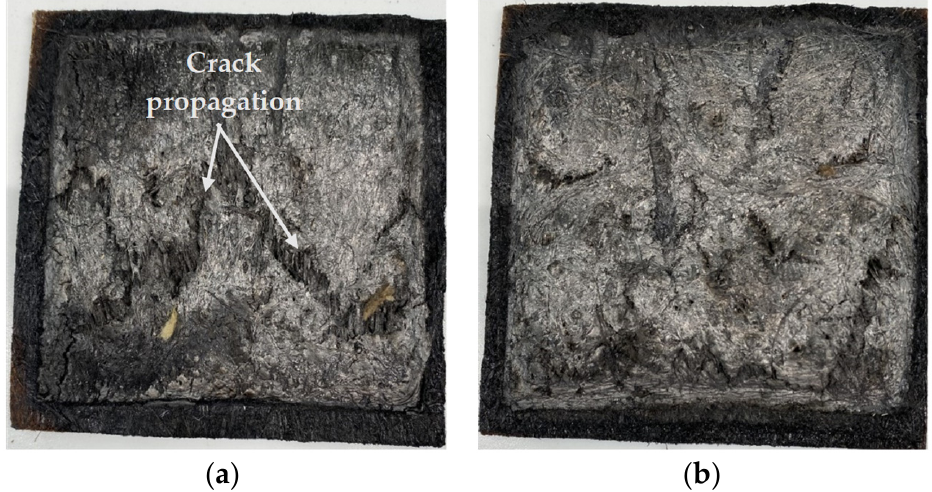
Figure 15. Outlook of the F1-coated biocomposites reinforced with ( a ) untreated and ( b ) alkali-treated hemp fibers after fire test.